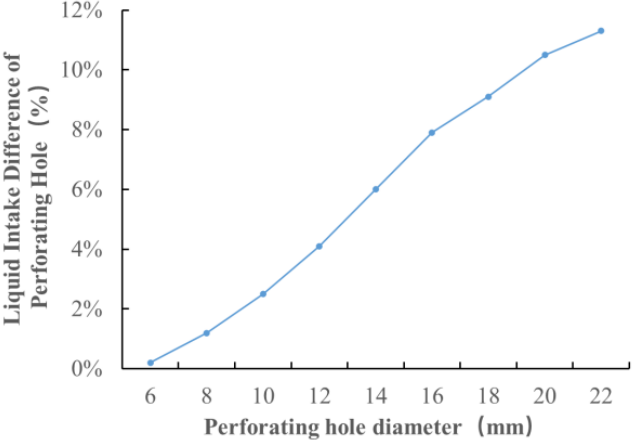
Figure 13. Difference in liquid inflow between clusters under different perforation diameters.